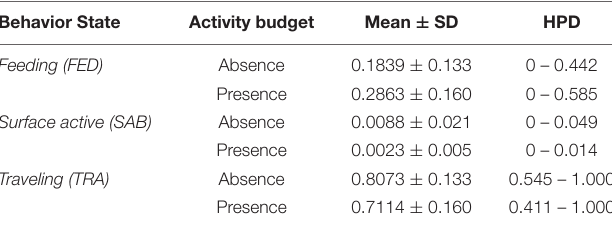
TABLE 9 | Activity budgets of whales during vessel presence and vessel absence situations, estimated by Monte Carlo